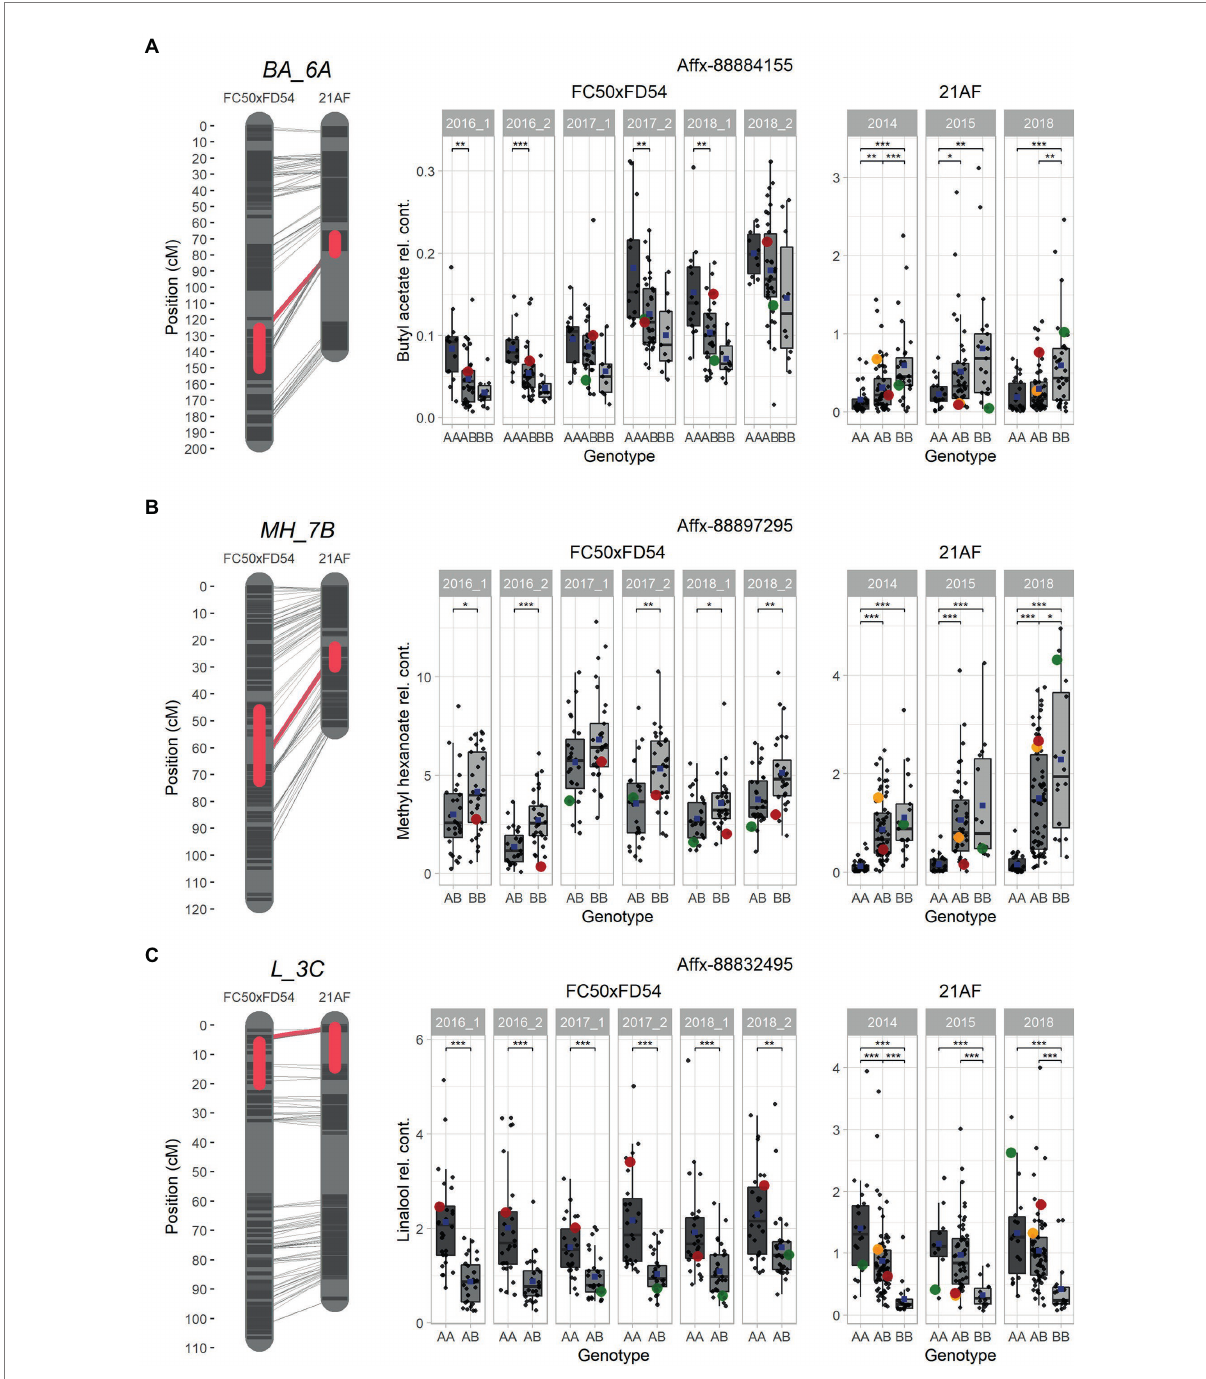
FIGURE 4 Selected major QTLs detected in the “FC50xFD54” and “21AF” maps, and boxplot of related VOCs for a common marker located in the QTL. (A) BA_6A QTL for acetate and octyl groups with Affx-8884155. (B) MH_7B QTL for methyl group with Affx-88897295. (C) L_3C QTL for terpene content with the Affx-88832495 marker. Red boxes on the left cover 1-LOD confidence intervals, and red line shows the SNP position in both maps. Markers colored in dark grey and chromosome in light grey. Right: Boxplot with each sample represented as a dot (progenies in grey, father line in red, mother line in green and hybrid for the “21AF” data in yellow), and the blue square indicates the average of each group. Significant levels p < 0.001 (***), p < 0.01 (**) and p < 0.05